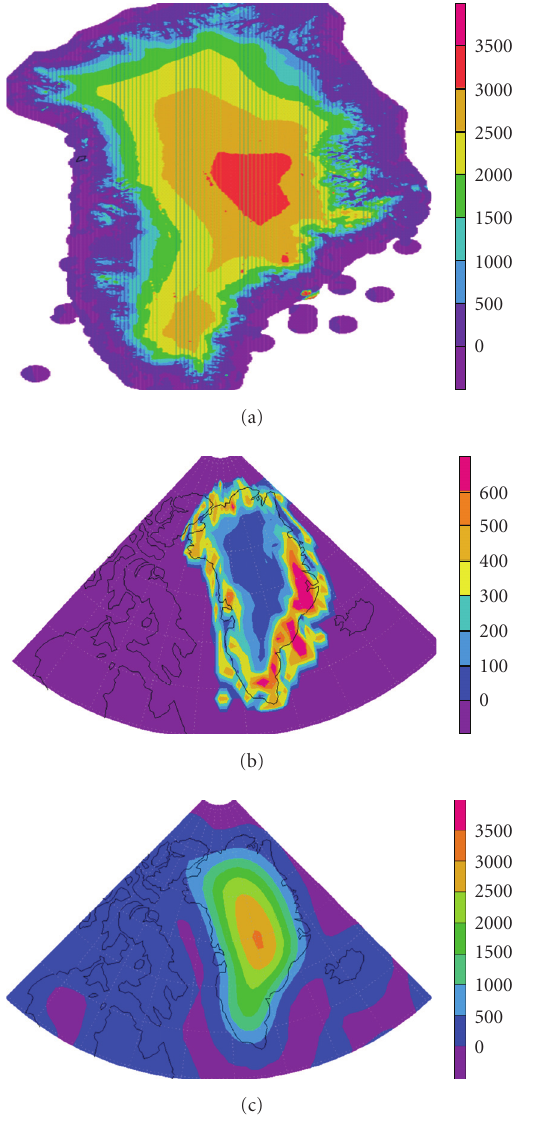
Figure 2: (a) ICEsat observed surface height of Greenland at a spatial resolution of 1 km; (b) ICEsat standard deviation of surface height; and (c) surface height in CAM3/CLM3 at T85 resolution.